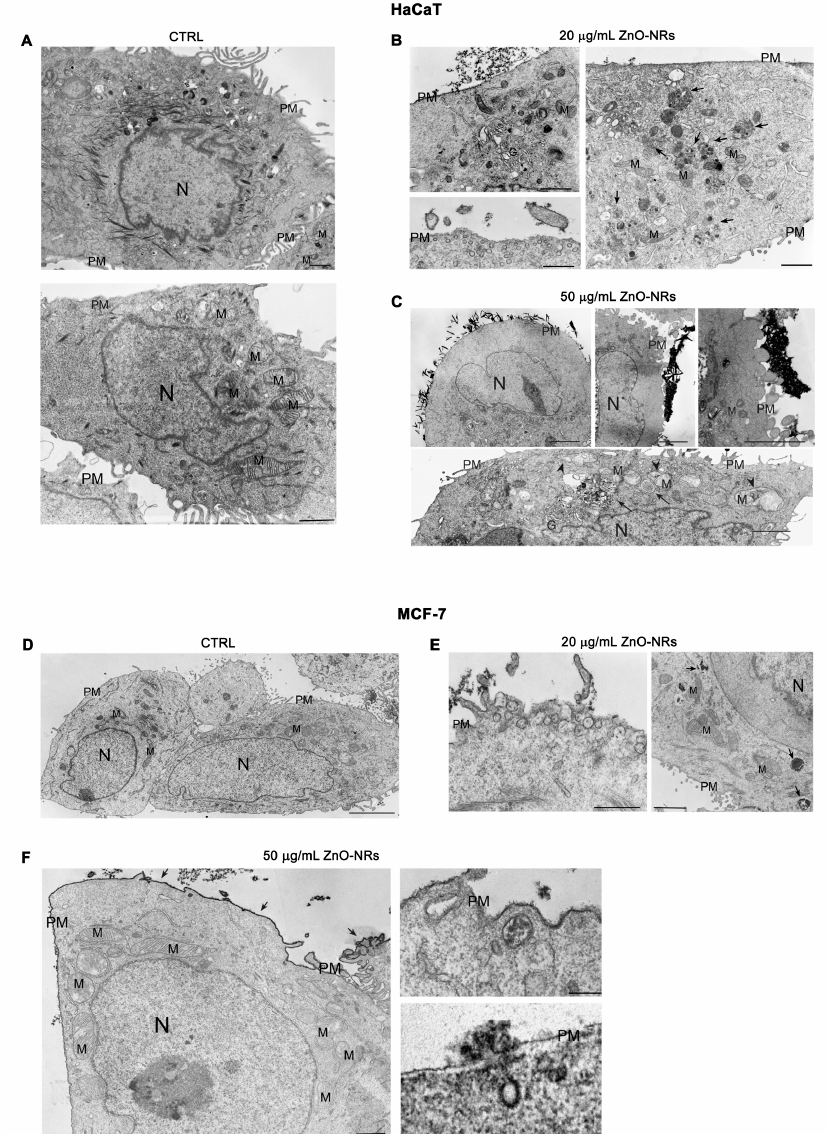
Figure 3. Ultrastructural analysis of HaCaT and MCF-7 cells after ZnO-NR treatment. HaCaT and MCF-7 cells were either untreated or treated with the indicated ZnO-NR concentration for 24 h. ( A ) TEM images of untreated HaCaT cells showing normal cellular morphology. Size bars, 1 µ m. ( B ) TEM images of HaCaT cells treated with 20 µ g/mL ZnO-NRs showing the extracellular presence and plasma membrane deposition of ZnO-NRs. Arrows point to autophagic vacuoles. Size bars, 1 µ m for the upper left and right image and 2 µ m for the lower left image. ( C ) TEM images of HaCaT cells treated with 50 µ g/mL ZnO-NRs showing increasing extracellular ( upper left ) and intracellular ZnO-NRs accumulation ( lower right ) as well as presence of autophagic bodies (arrows) and damaged mitochondria with disruption/loss of the cristae (arrowhead) ( lower image). Size bars, 2 µ m for the upper image and 1 µ m for the lower left and right images. ( D ) TEM image of untreated MCF-7 cells showing cancer cell morphology. Size bar, 5 µ m. ( E ) TEM images of MCF-7 cells treated with 20 µ g/mL ZnO-NRs showing presence of ZnO-NRs along the microvilli of the plasma membrane, in pinocytic vacuoles localized beneath the plasma membrane ( left image), and also intracellularly (arrows in right image). Size bars, 0.5 µ m ( left ) and 1 µ m ( right ). ( F ) TEM images of MCF-7 cells treated with 50 µ g/mL ZnO-NRs showing deposition along the entire surface of the plasma membrane (arrows) and in intracellular vacuoles. Size bars, 1 µ m ( left image) and 0.2 µ m ( right image). In all panels: N, nucleus; M, mitochondrion; PM, plasma membrane; G,